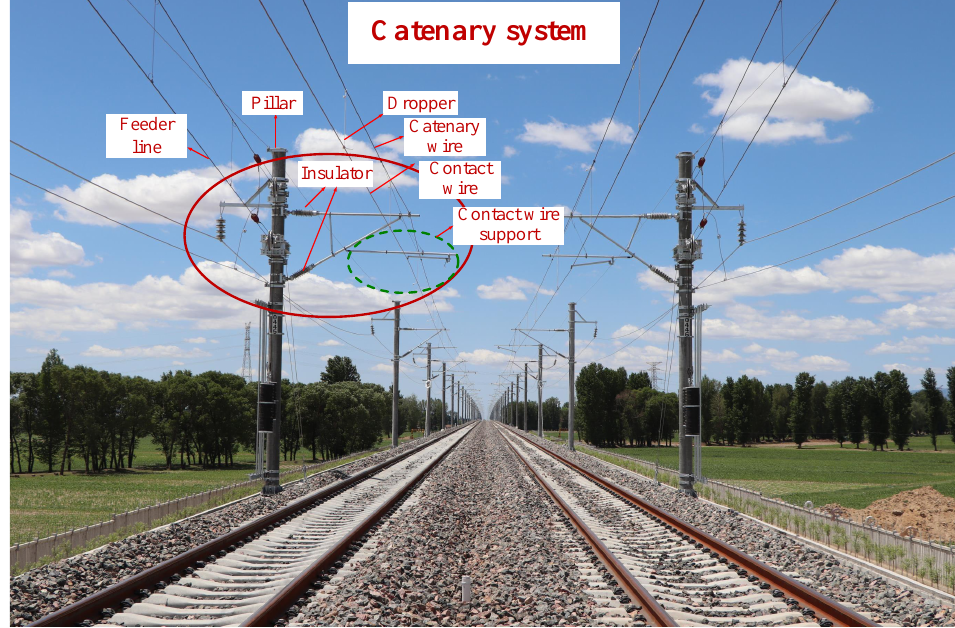
Figure 1. Scene of a catenary